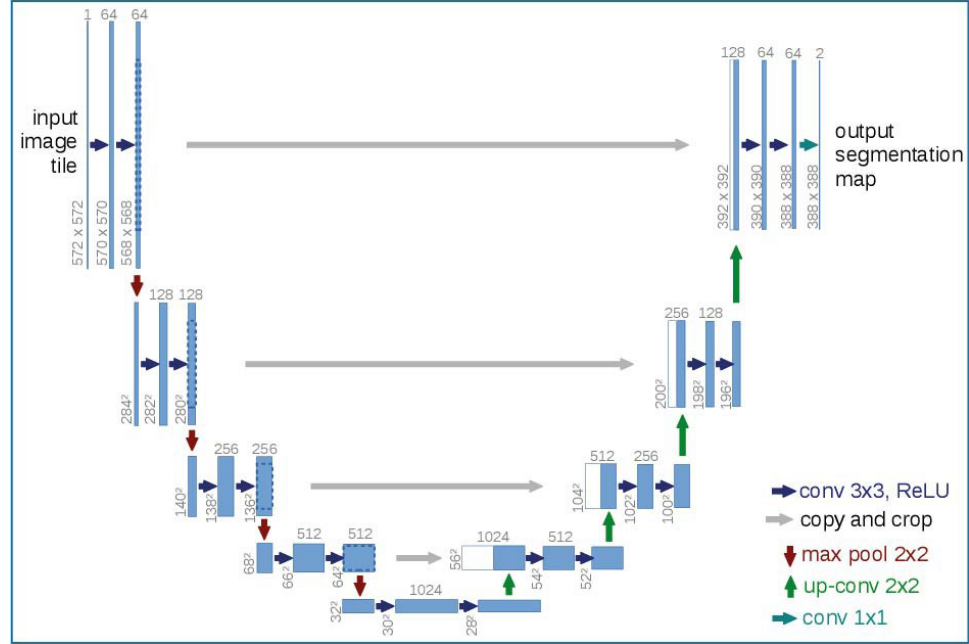
Figure 2. The architecture of the U-Net model and this is from the reference [43]. Each blue box corresponds to a multi-channel feature map. The number of channels is denoted on top of the box. The x-y-size is provided at the lower left edge of the box. White boxes represent copied feature maps. The arrows denote the different operations.